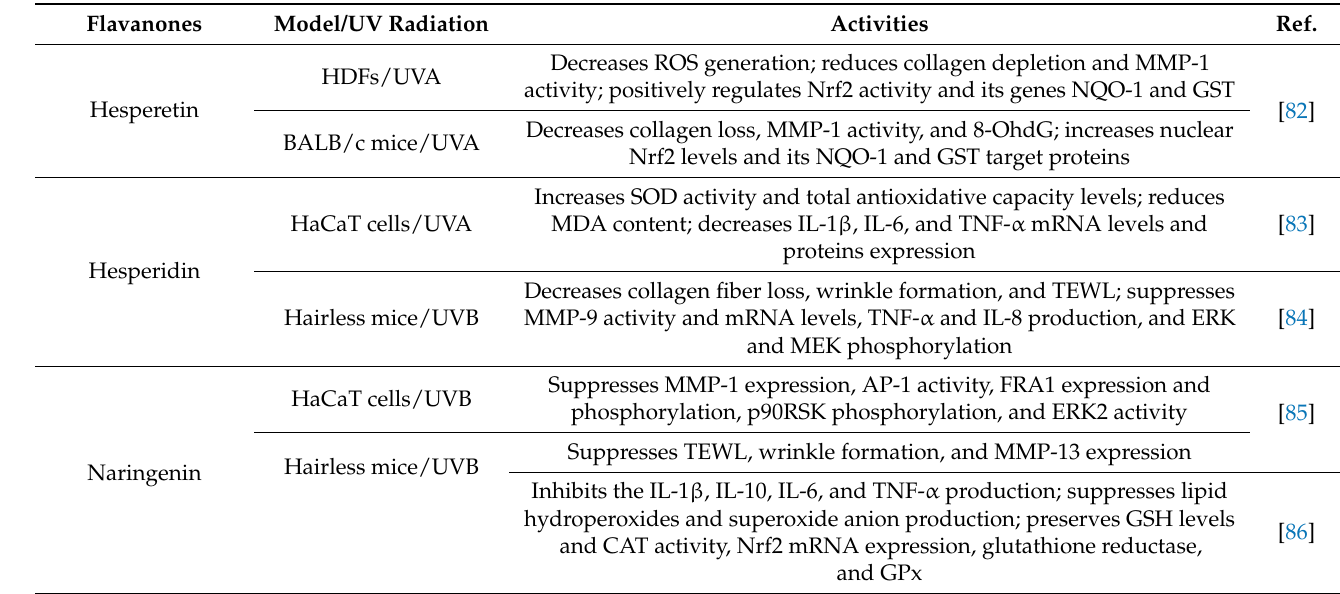
Table 3. Anti-photoaging activity of the